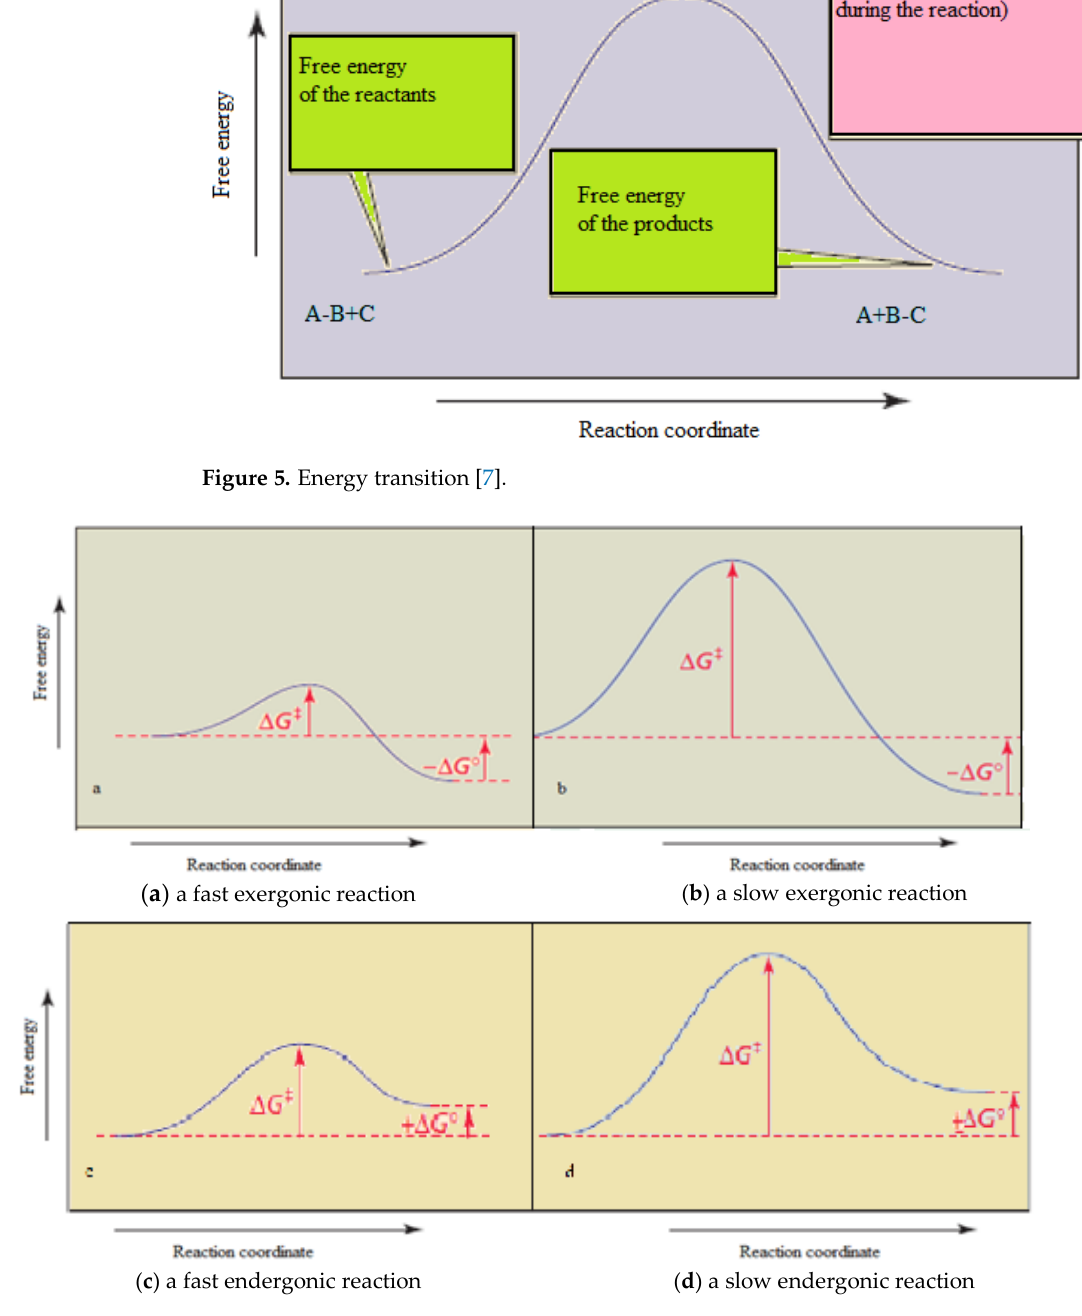
Figure 6. Types of reactions [7].